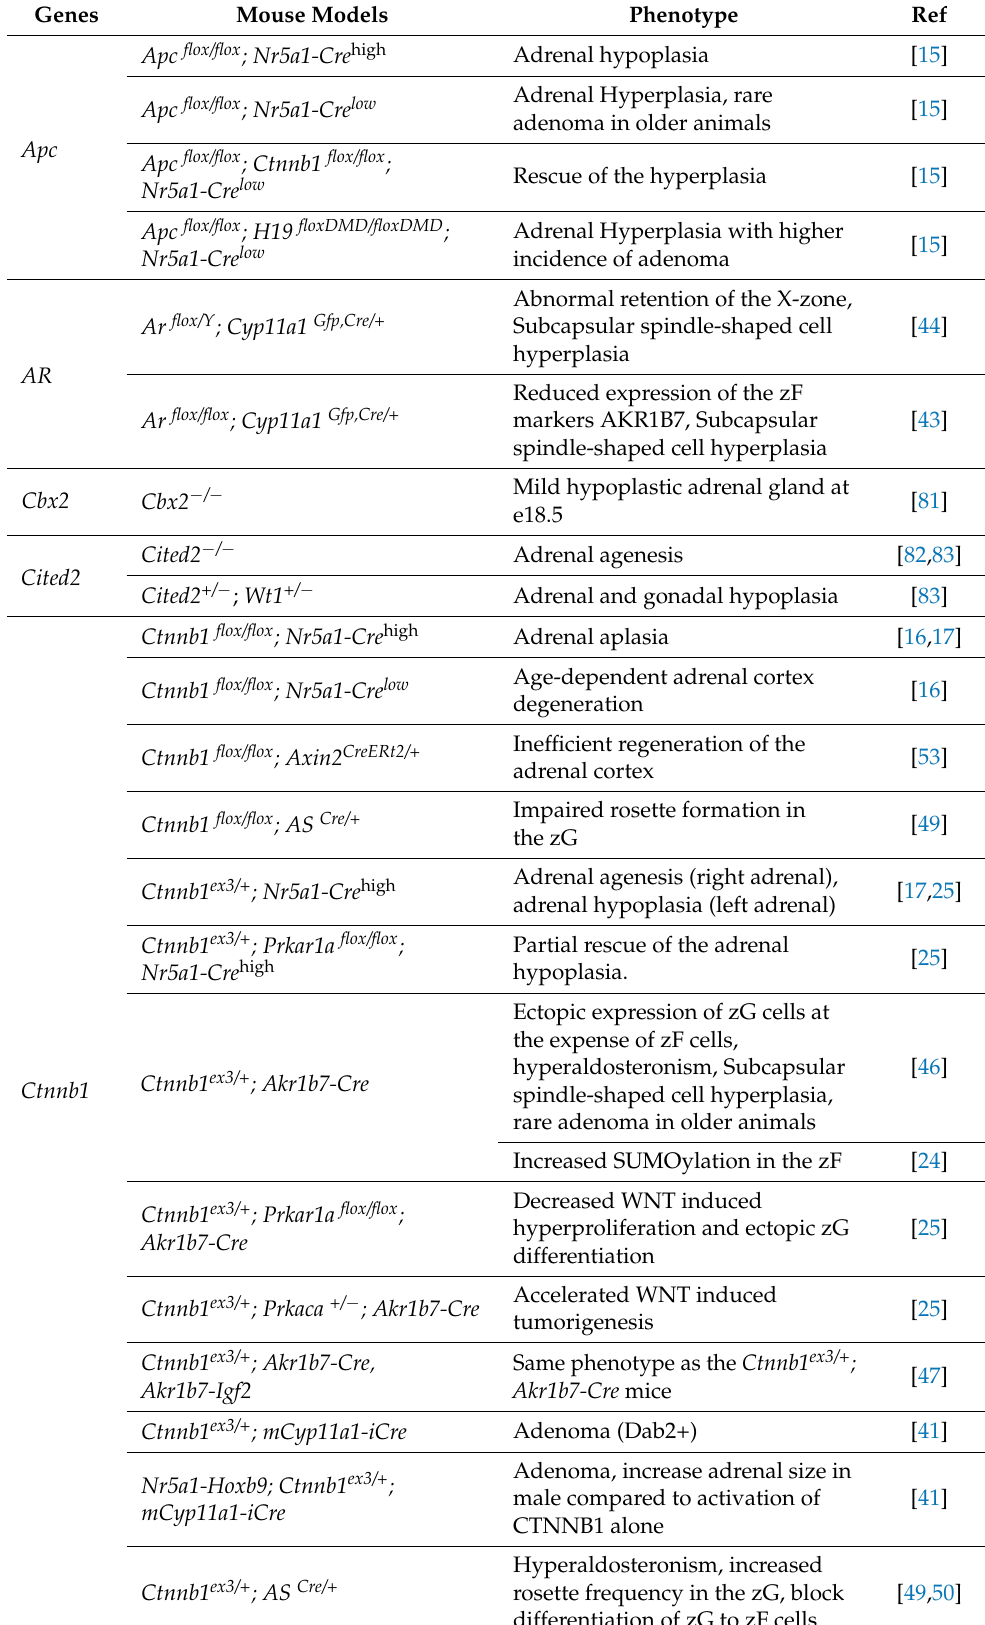
Table 2. List of mouse models evaluating the development, zonation and maintenance of the adrenal